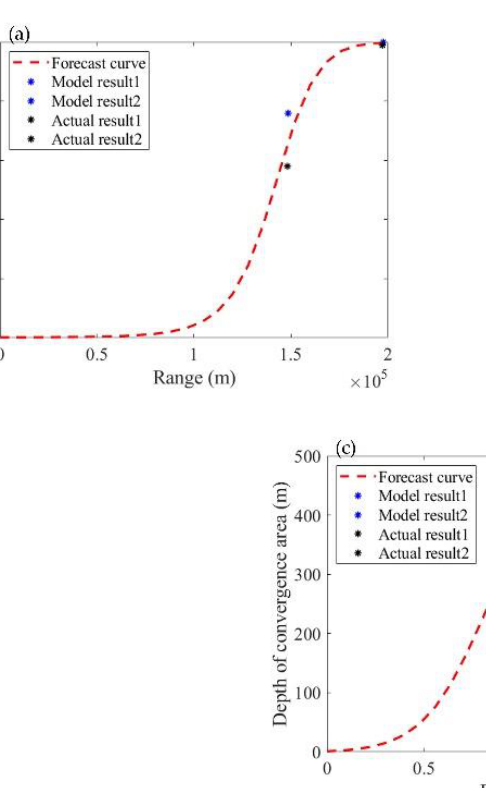
Figure 14. The forecasting curve of the depth of the convergence area (the red dotted line) and the calculating results of the model (blue dots) and actual ocean front (black dots) on 1 January (SD =